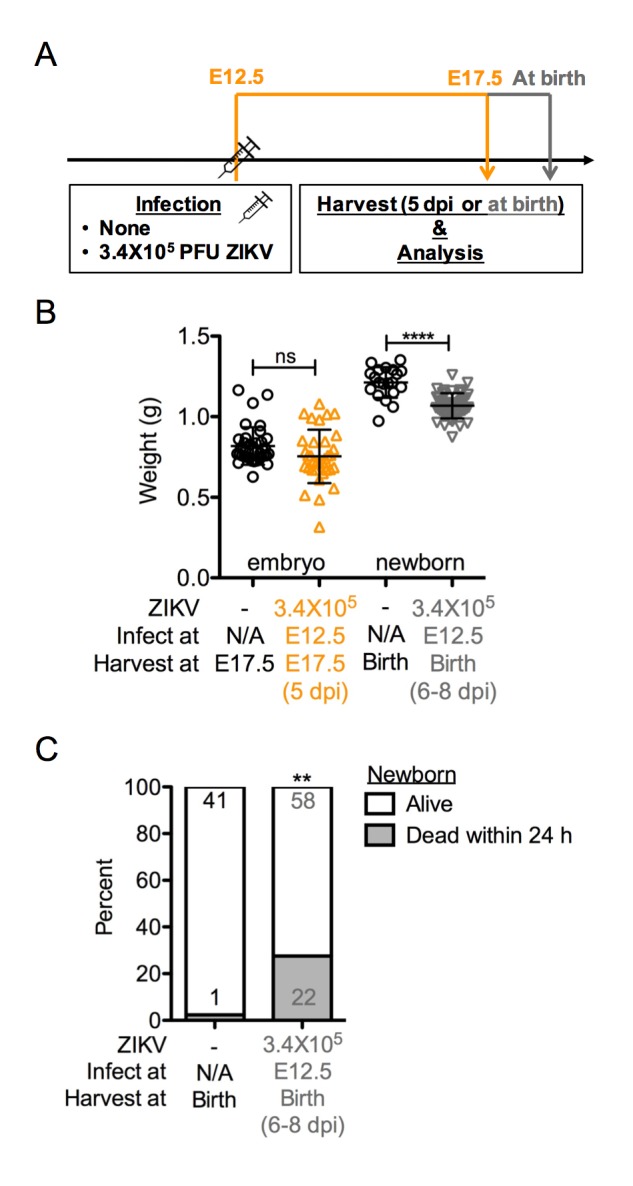
Newborns of dams infected at E12.5 exhibit a significant rate of early postnatal death.Pregnant dams were infected with 3.4 × 105 PFU at E12.5, and sacrificed 5 dpi at E17.5 or allowed to carry to term. Both dams and newborns were examined within 24 h after giving birth. (A) Scheme of infection. (B) E17.5 embryo and newborn weight. Data shown are mean with SD. (ns, not significant; **** p<0.0001 compared with the uninfected group by Student t test) (C) Newborn viability. Numbers on bars indicate newborns that were alive (top) or born alive but dead within 24 h after birth (bottom). (ns, not significant; ** p<0.01 compared with numbers in uninfected group by Fisher’s exact test). Data for all panels are pooled from 2–3 independent experiments. N/A, not applicable.